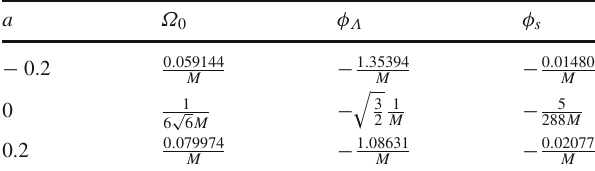
Table 7 The quantities Ω 0 , φ Λ , φ s in Eqs. (50)–(52) with different values of the spinning black hole at the